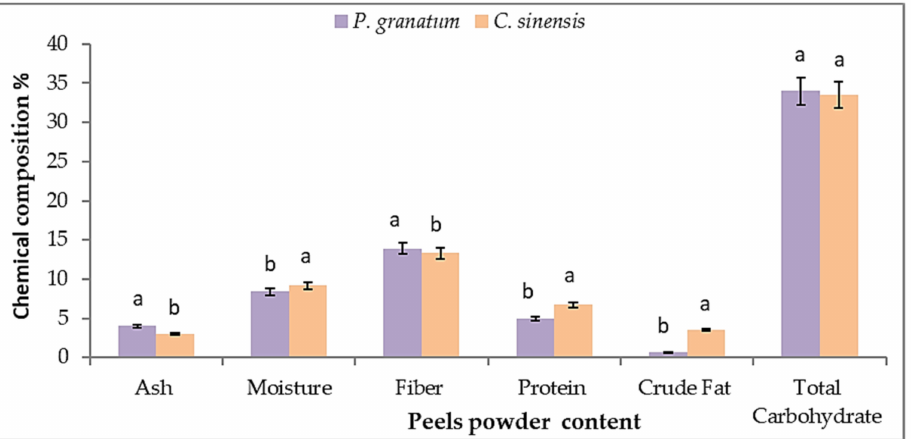
Figure 1. Chemical composition of P. granatum and C. sinensis peel powder (%). Each value is a mean ( ± SD) of three replicates. The different letters on the same bar show a significant difference according to Duncan’s test at p ≤ 0.05.